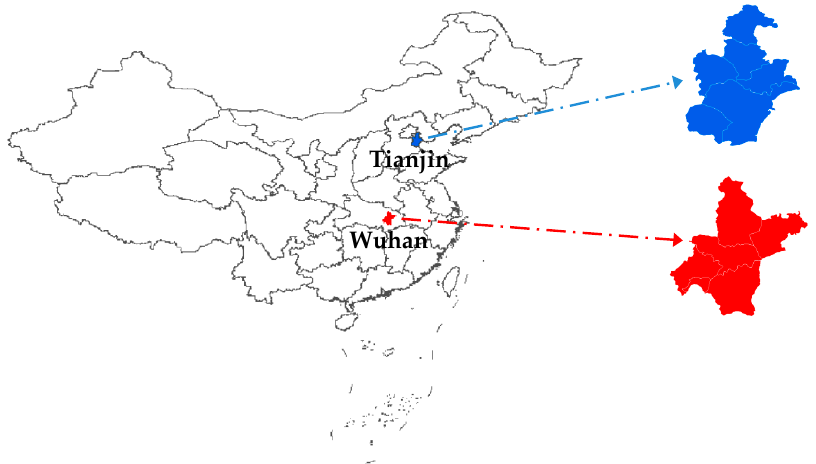
Figure 6. Geographical locations of the study areas.